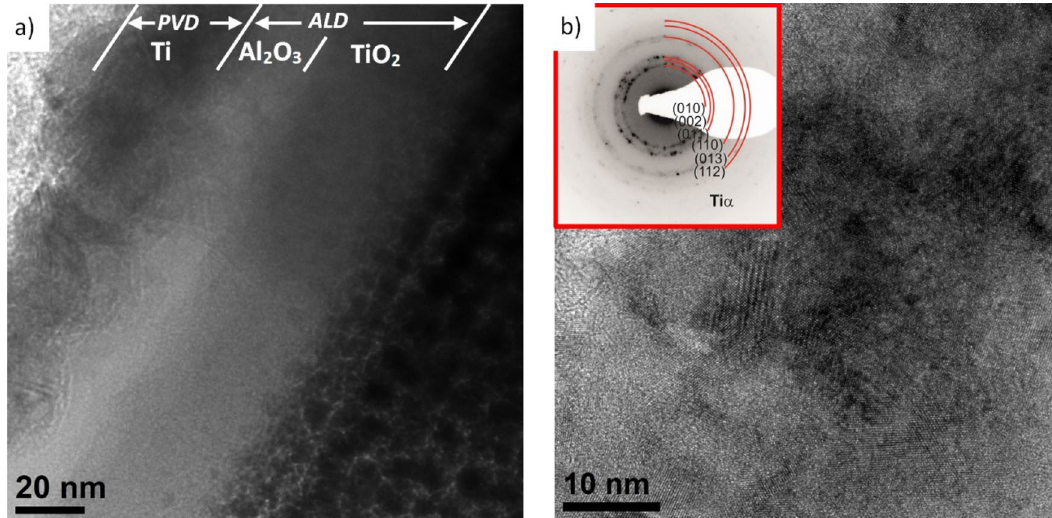
Figure 3. Structure (HR-TEM) of Ti/Al 2 O 3 + TiO 2 hybrid coating on AE 42 alloy substrate: ( a ) the entire cross- section of the coating, ( b ) Ti layer (with diffraction